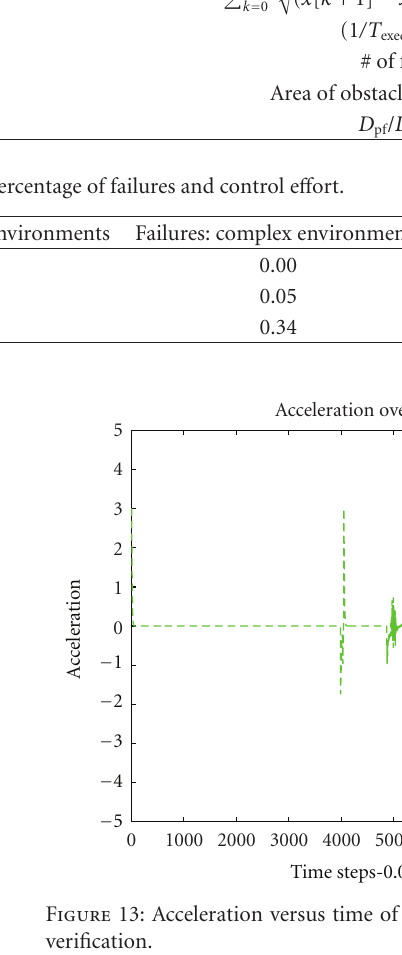
Figure 12: Example of the fuzzy logic controller for constraint veri- fication.